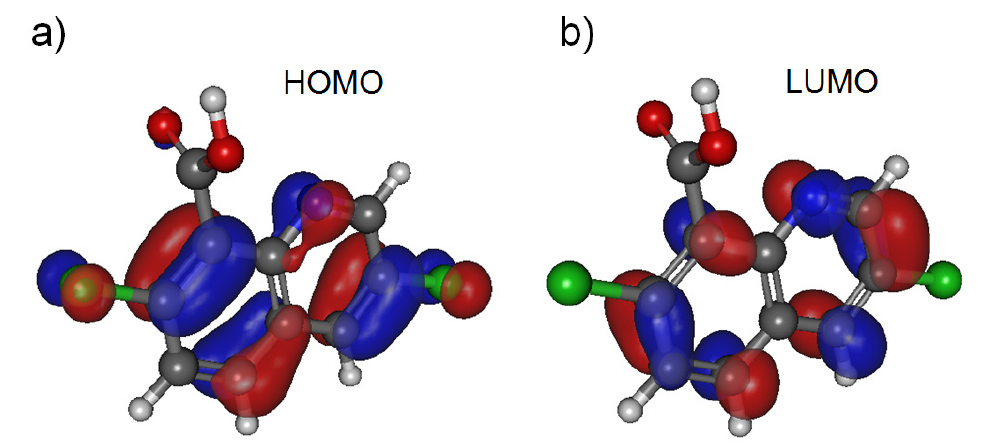
Figure 4: a) HOMO and b) LUMO maps of space distributions of quinclorac at the MP2/6-311++G(2d,2p)